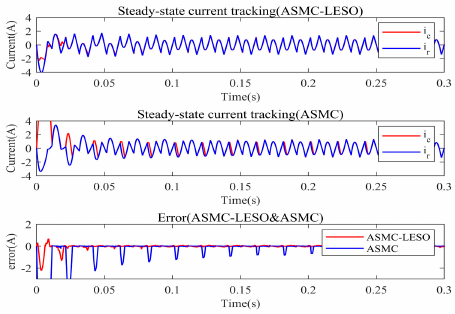
Figure 11. Tracking and error comparison curves of the ASMC-LESO and ASMC.